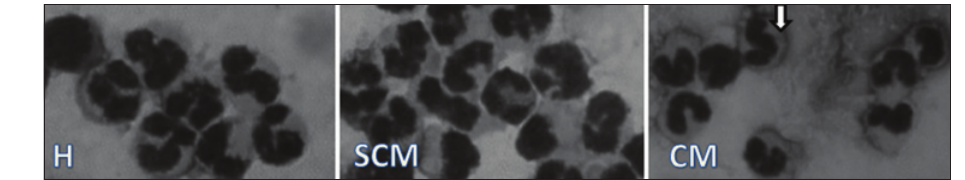
Figure-1: Milk neutrophils in healthy, subclinical, and mastitis Karan Fries cows ( ↓ indicates immature neutrophils).